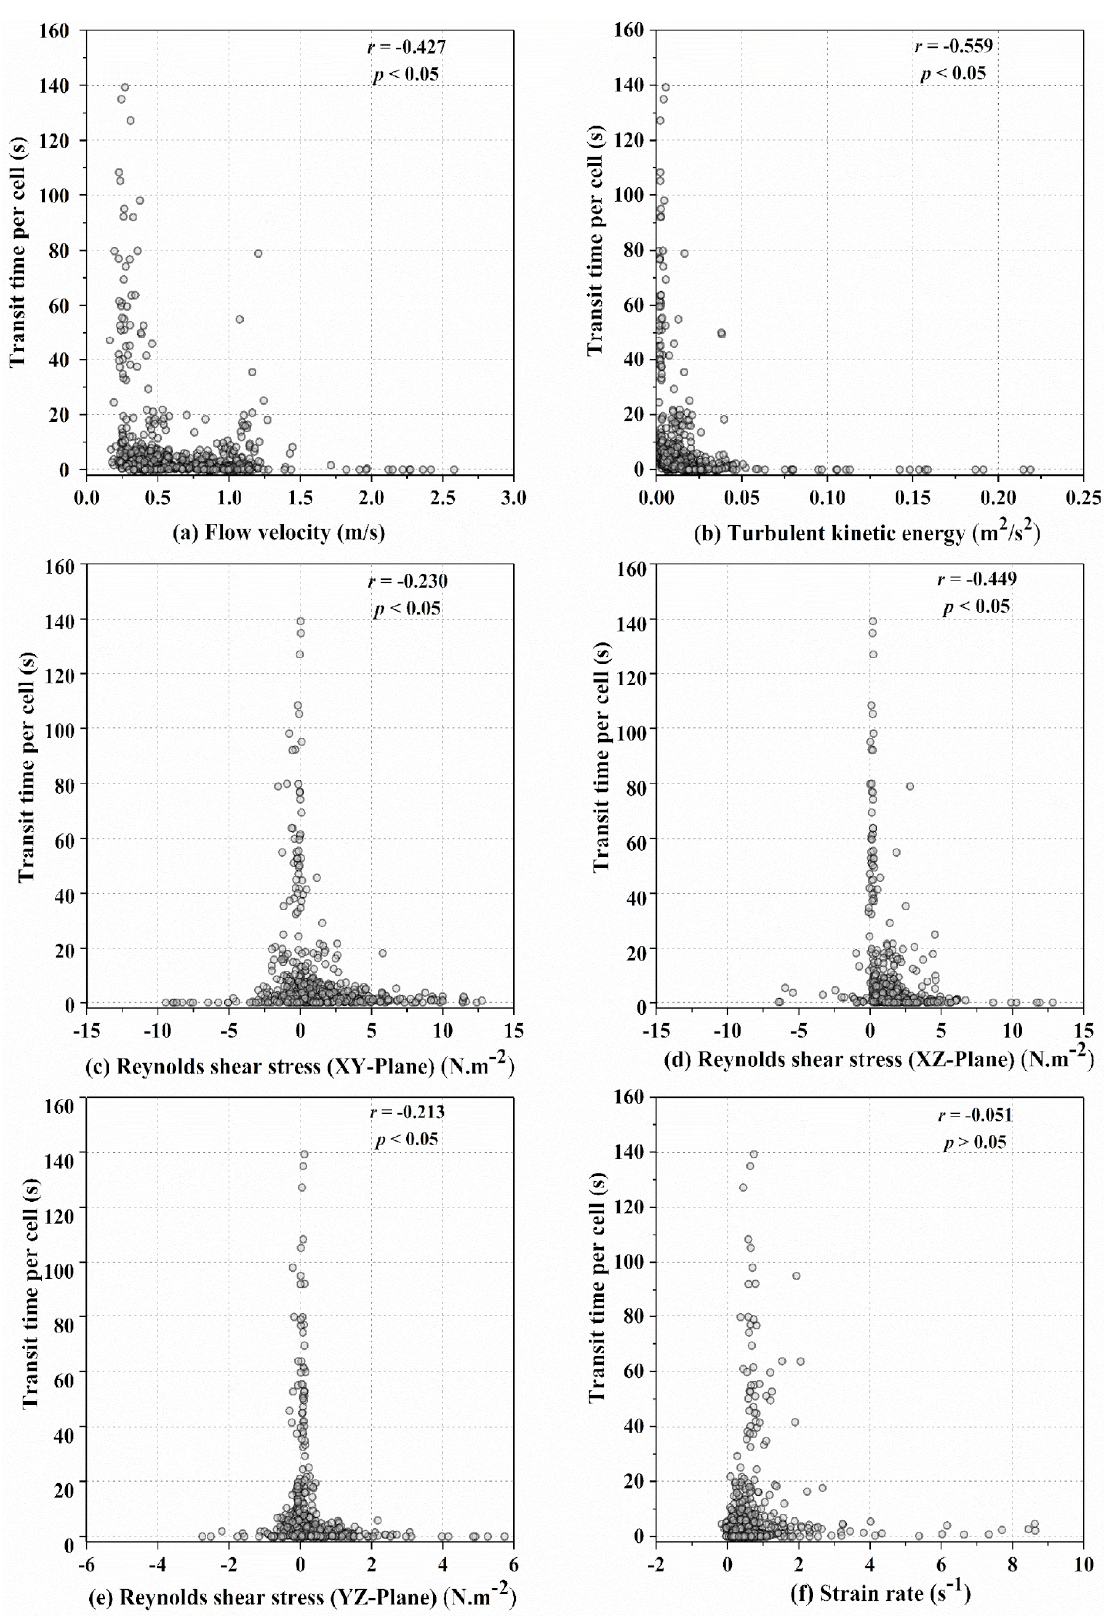
Figure 4. Distribution of fish transit time in cells versus ( a ) flow velocity (m/s), ( b ) TKE (m 2 /s 2 ), ( c )